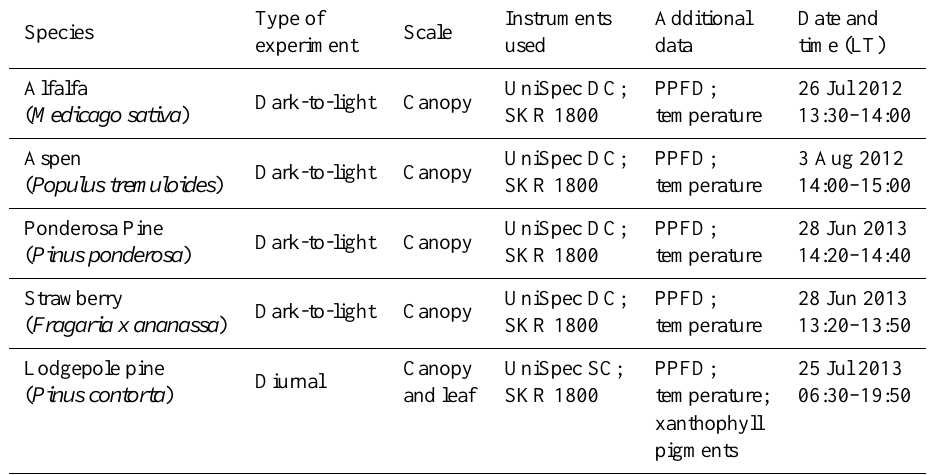
Table 2. Summary of types of experiment undertaken by species, including the sensors that were used and whether spectral data were collected at the canopy level or leaf